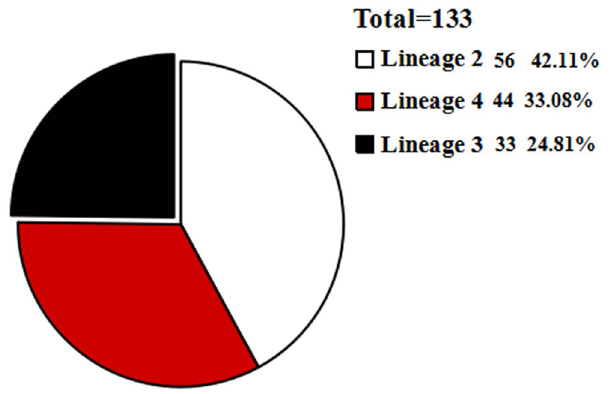
Figure 1. The distribution of M. tuberculosis strains lineage in the Xinjiang. The Lineage 2 accounts for 42.11%, the Lineage 3 and the Lineage 4 account for 24.81% and 33.08%,